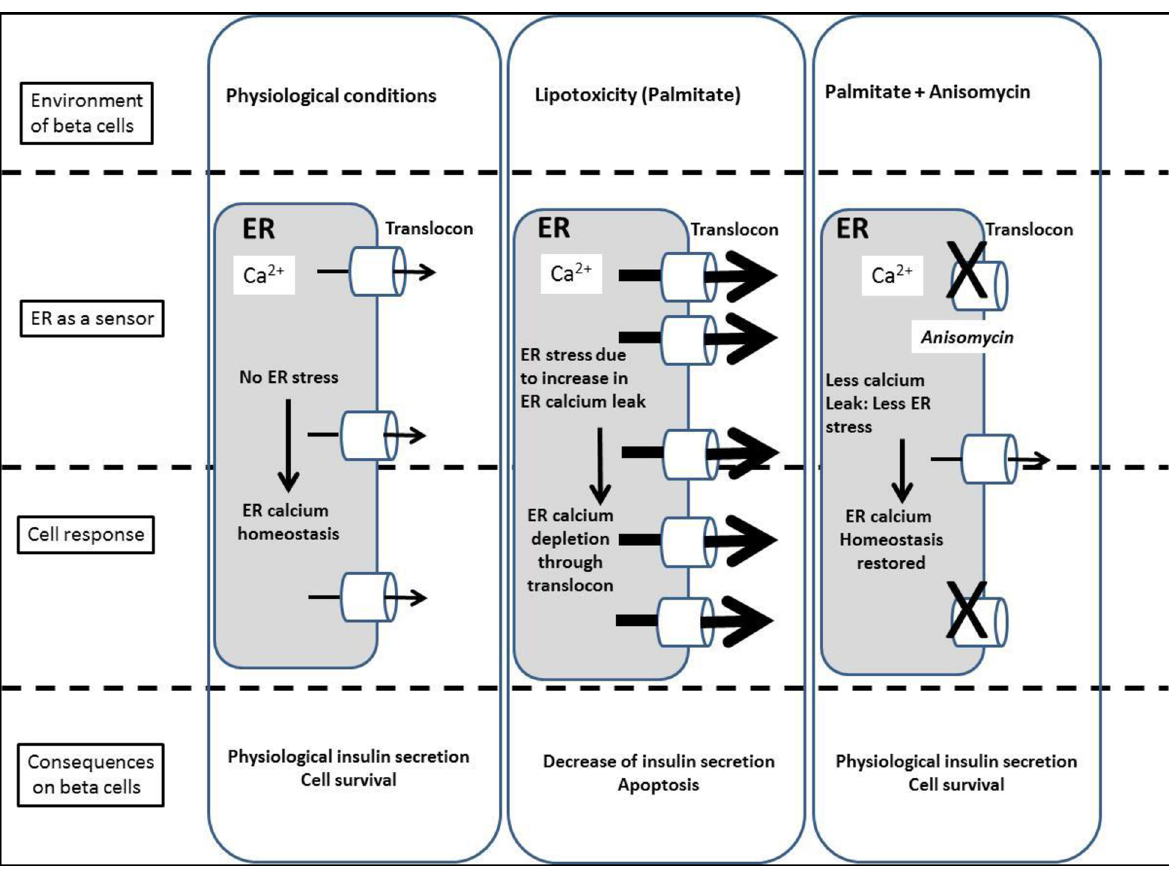
Fig 5. Model of translocon implication in pancreatic beta cells. Chronic palmitate causes ER calcium depletion due to a greater ER calcium leak through the translocon, triggering ER stress and decreased glucose-stimulated insulin release, indicating an altered metabolism-secretion coupling. Addition of anisomycin reduced ER stress and ER calcium leak from translocon, leading to restored insulin